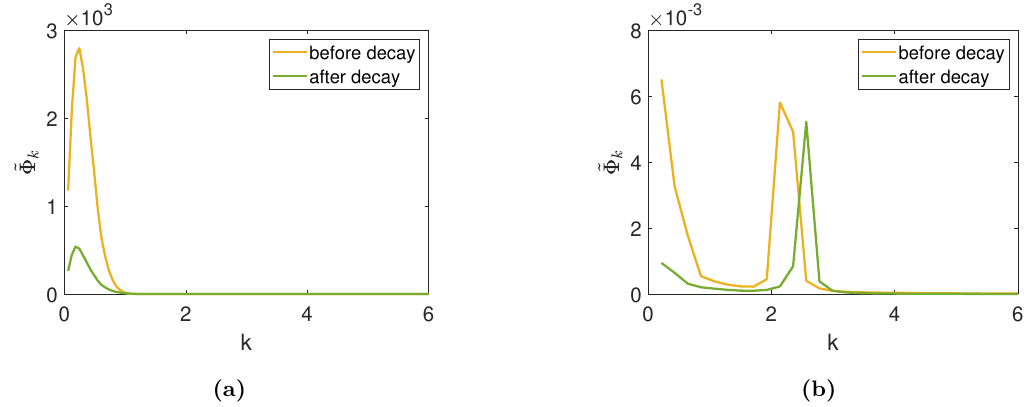
Figure 15. Power spectra of φ ( x ) over the whole lattice (left plot) and over a small rectangular area outside the CSQ along the positive x -axis (right plot). Typical results before the decay (orange line, t ≈ 3766 T 0 ) and after the decay (green line, t ≈ 5793 T 0 ) are shown. The constituent elementary Q-balls with ω = ± 0 . 86 are initially placed at d = 4 . 0 away from each